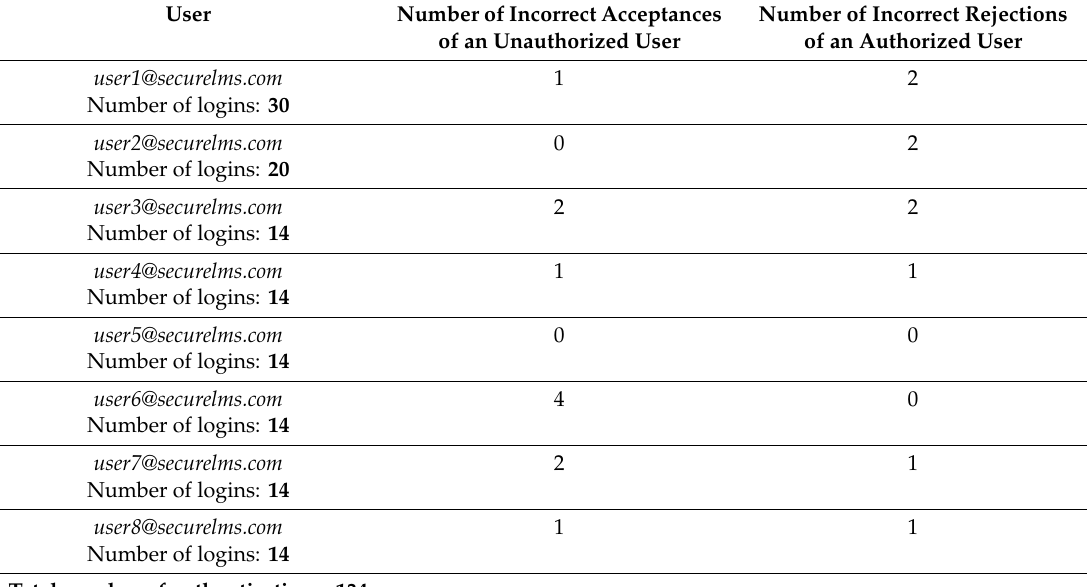
Table 3. The accuracy of authentication.